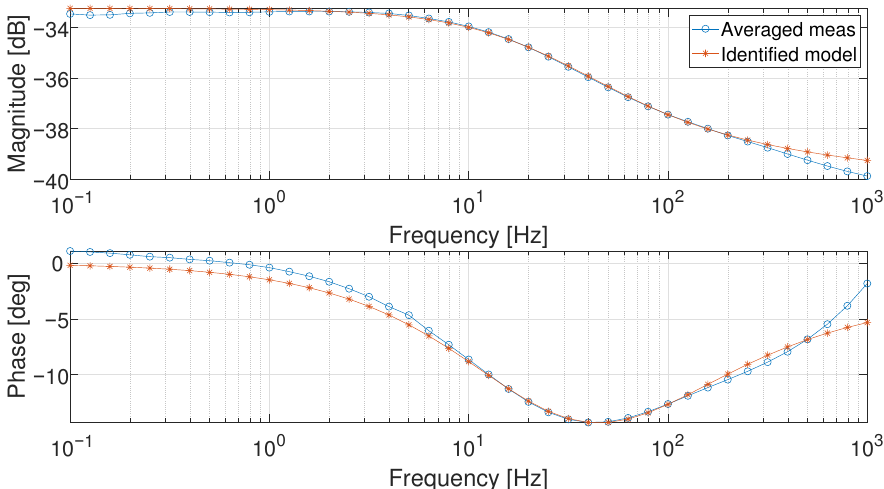
Figure 21. Bode diagram of the averaged measurement (circle marked) and identified model (asterisk marked) at